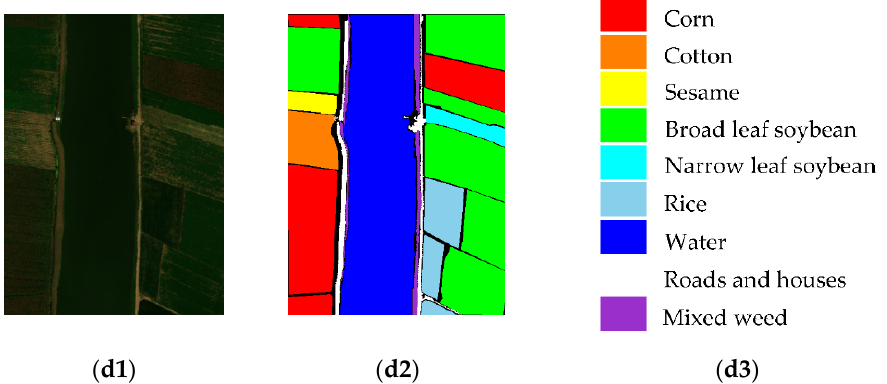
Figure 1. Real HSIs. ( a1 – d1 ) represent the false-color images of the Pavia Centre, Salinas, Chikusei, and LongKou images, respectively. ( a2 – d2 ) represent the standard classified images (i.e., validation data) of four real HSIs, respectively. ( a3 – d3 ) represent the legends for all classes of four real HSIs, respectively.